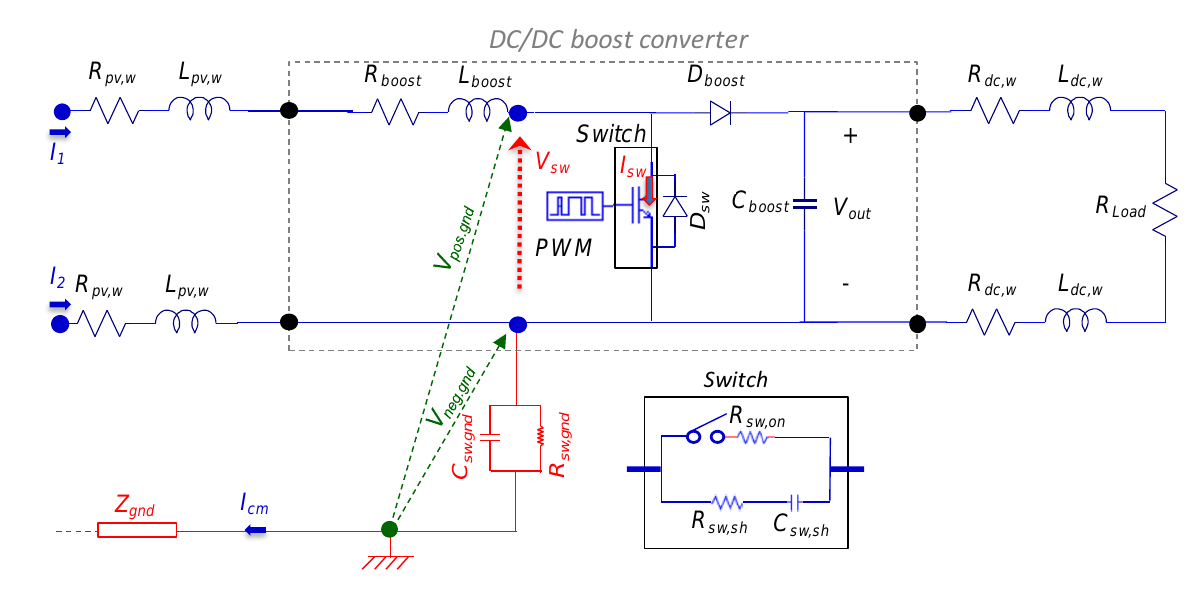
Figure 9. DC/DC boost converter circuit.